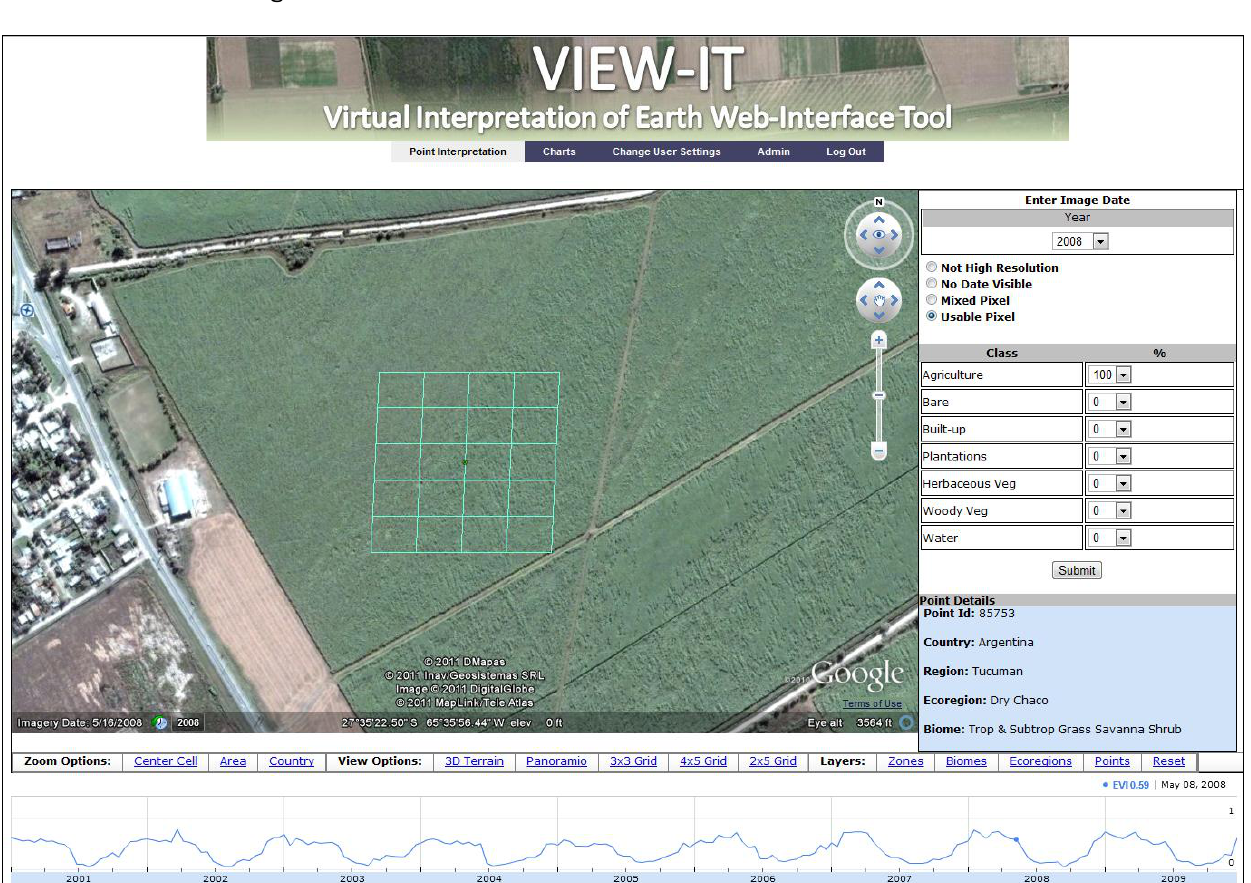
Figure 2. The VIEW-IT interpretation window with light-blue sample and its internal 4 × 5 grid (each cell covers 5% of the sample’s total area), overlaid on Google Earth imagery. The entire square sample is 250 × 250 m, the nominal size of a MODIS pixel and its location and orientation is centered on a MODIS pixel projected to geographic coordinates (latitude, longitude) from the Goode Homolosine projection. The sample is in a sugar cane field near Juan Bautista Alberdi, Argentina. The high resolution image is from the Quickbird satellite, as indicated by the DigitalGlobe copyright (bottom middle of Google Earth window), and the image was acquired in 16 May 2008 (bottom left corner of Google Earth window). The EVI profile shows an annual cycle of sugar cane growth and harvest, with a value of 0.59 on 8 May 2008 (dot on EVI graph, data displayed top right of graph) coinciding with the ground conditions seen in the Google Earth imagery. Note that the field was harvested shortly after this image was acquired, as indicated by a lower 0.24 EVI on 9 June 2008. The blue icon in the top left of the image on the road represents a clickable Panoramio photograph. See the online supplemental materials for a higher resolution version of this